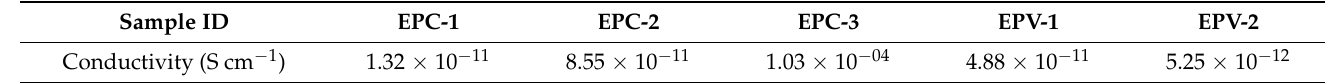
Figure 10. TGA analysis of phase-1 ( A ), phase-2 ( B ), and phase-3 ( C ) composites. Table 3. Conductivity data of samples with carbon fiber fabric and Vulkasil as